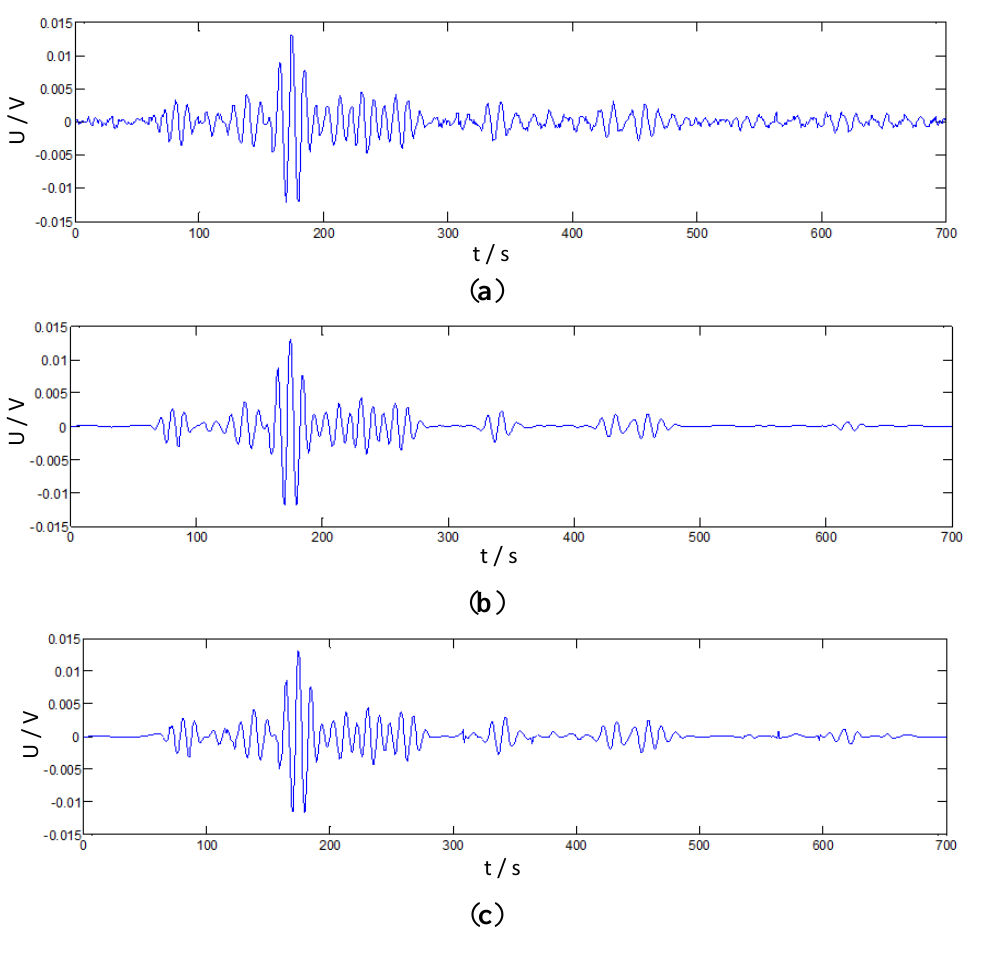
Figure 9. Denoising signals via actuator–sensor path P2-P10. ( a ) Raw Lamb wave damage signal via path P2-P10; ( b ) RSGWT Denoising of Lamb wave damage signal via